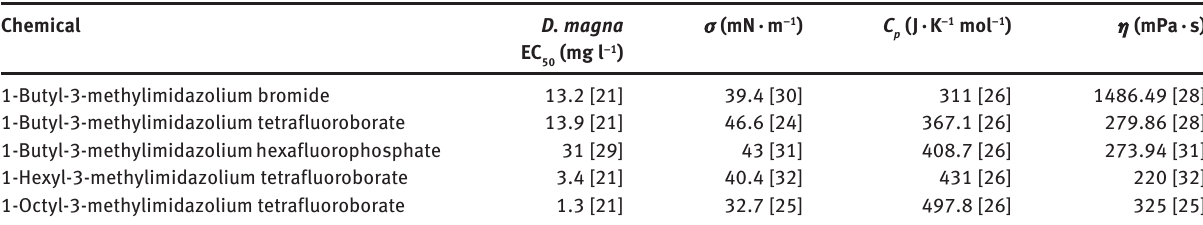
Table 4: Physicochemical and toxicological ( Daphnia magna ) properties used in the QSAR for previous studied ILs.